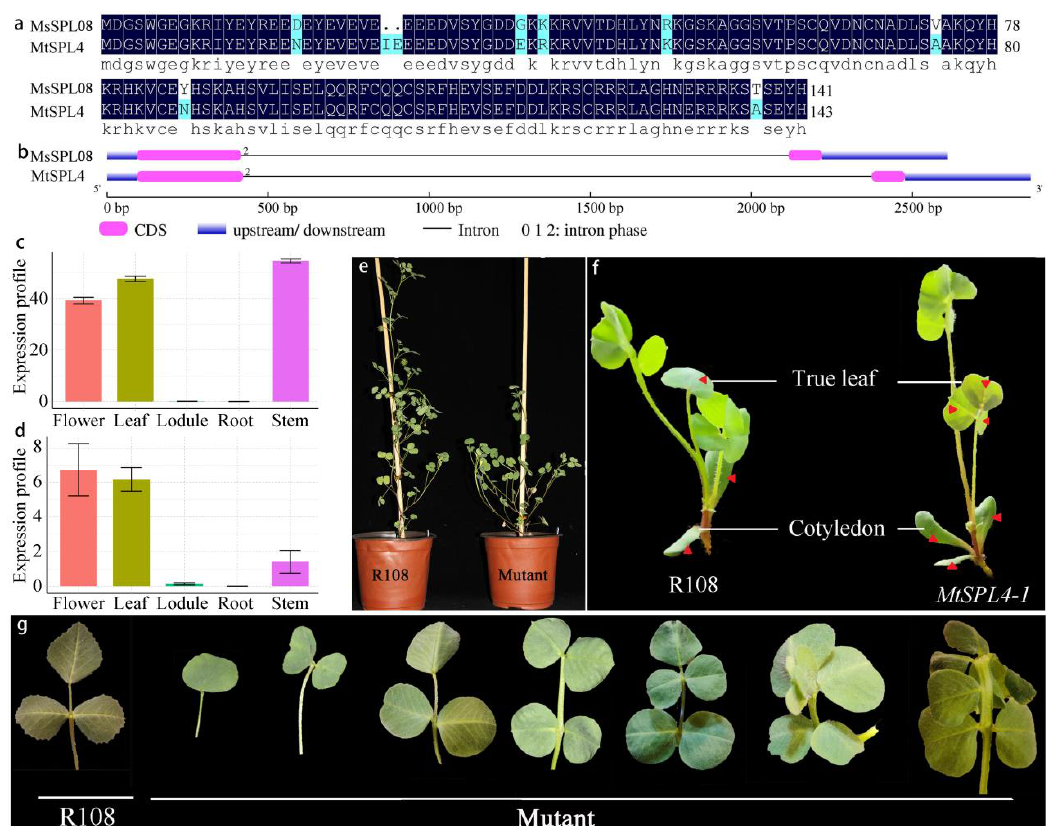
Figure 9. Paralogous of MsSPL08 isolation and functional analysis. ( a ) MsSPL08 and MtSPL4 multiple sequence alignment, and ( b ) gene structure comparison. Transcript levels of MsSPL08 ( c ) and MtSPL4 ( d ) in alfalfa and M. truncatula . ( e ) The aboveground phenotype of wild type and mutant plant. ( f , g ) Seedling leaflet number comparison between wild type and mutant plant, the red triangle indicate the cotyledon and true leaf.